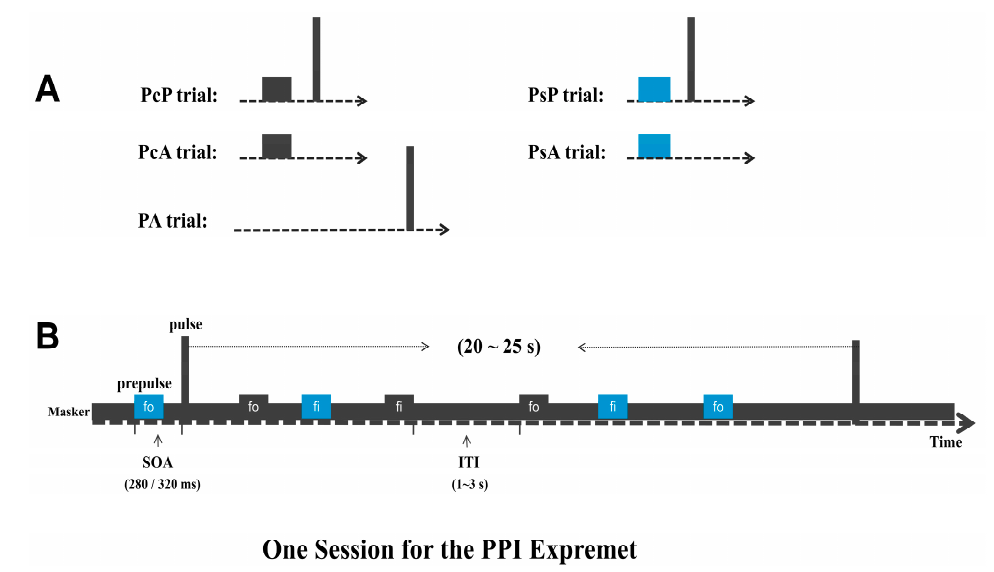
Figure 1. ( A ) Five types of trial. PcP: Trials with prepulse/masker co-location + startling pulse. PsP: Trials with prepulse/masker separation + startling pulse. PcA: Trials with prepulse/masker co-location alone (no startling pulse); PsA: Trials with prepulse/masker separation alone (no startling pulse). PA: Trials with startling pulse alone. ( B ) Flowchart describing the experimental session design. SOA: Stimulus onset asynchrony (onset to onset), ITI: inter-trial